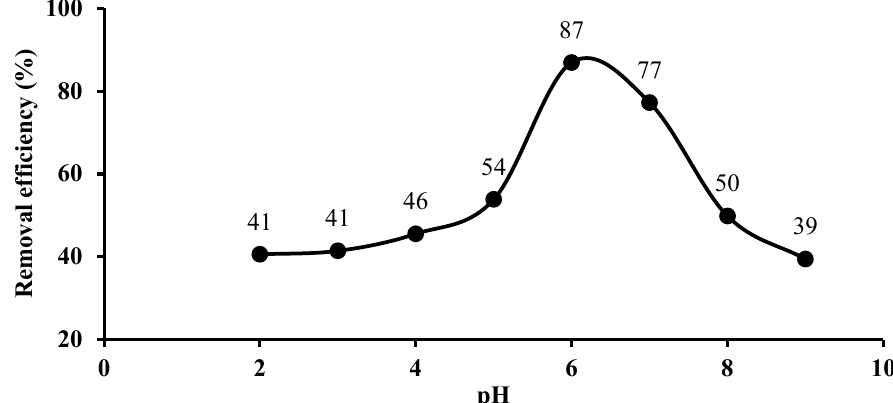
Figure 7. Effect of pH on the removal of Pb(II) ions from aqueous solution using Si-TS-SSIL.